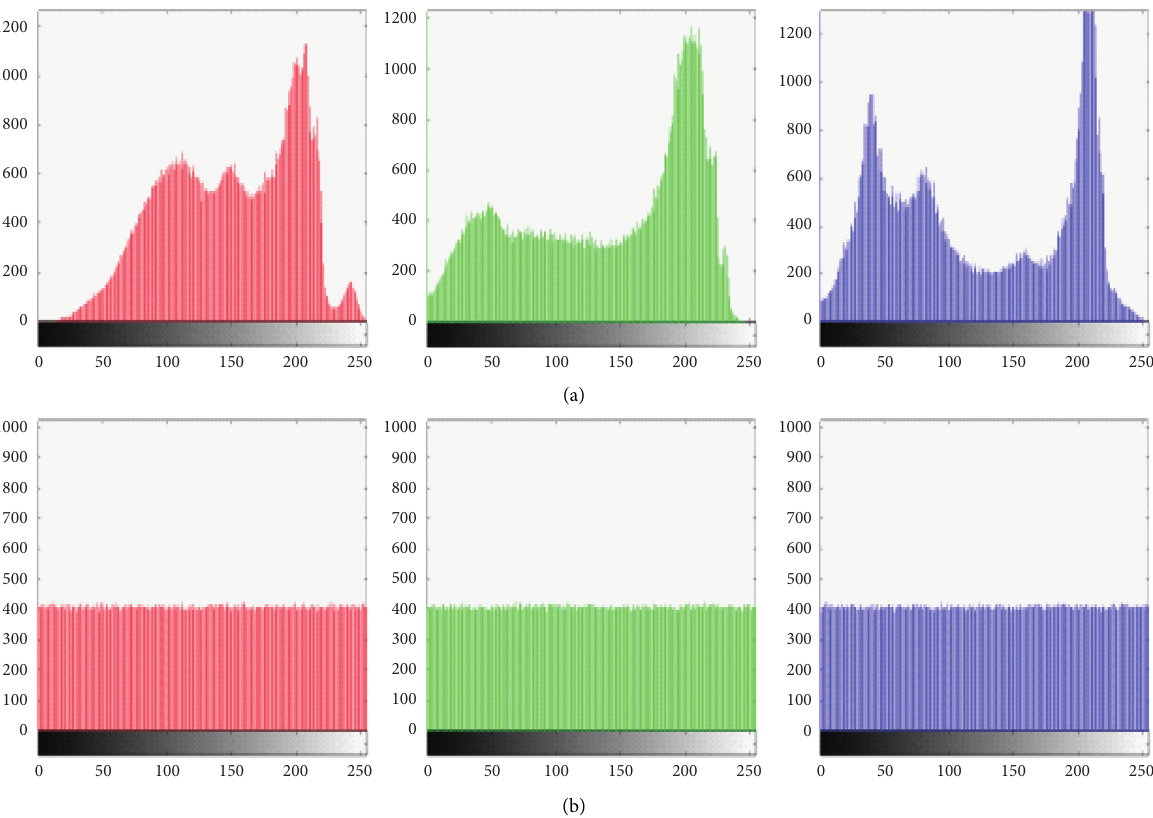
Figure 9: Histogram distribution for plain composite image in Figure 4(a) (a) and the cipher composite image in Figure 4(b)